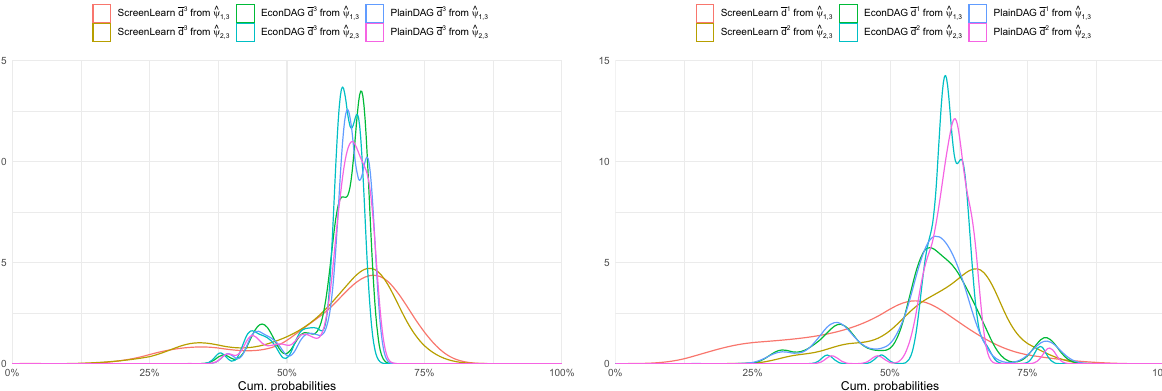
Figure 5: Kernel density plots of cumulative treatment probabilities for T 2010 = . In the left panel, estimated probabilities of d ¯ t 3 ∗ are shown while the right panel shows estimated probabilities for d ¯ t 1 ∗ and d ¯ t 2 ∗ .